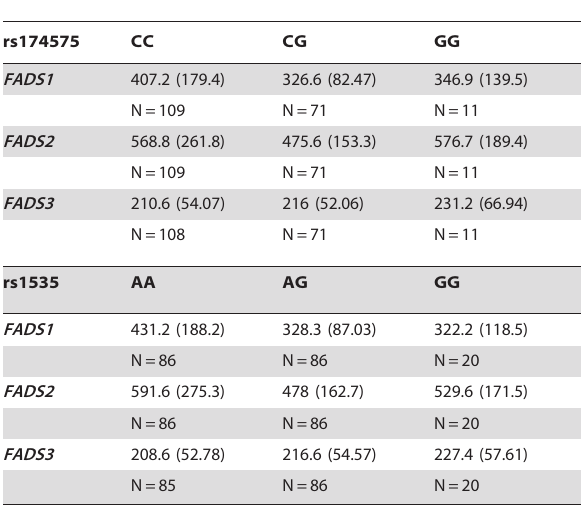
Table 3. Means (SD) of human brain expression scores, differentiated across genotype of the candidate variants from Table